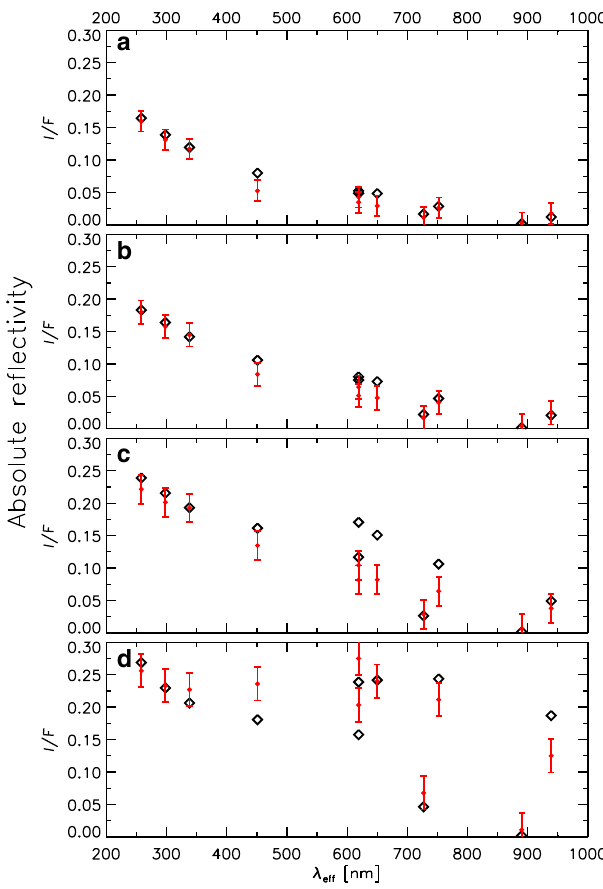
Fig. 3 Radiative transfer model fi t to the limb re fl ectivity scans. Panels show the re fl ectivity spectra from Fig. 2 (rhombs) and the limb-model results for the hazes at different altitudes (red dots with error bars). a z = 140 km, N p = 500 cm − 3 , H aerosol = 19 km. b z = 120 km, N p = 250 cm − 3 , H = 20 km. c z = 90 km, N = 100 cm − 3 , H = 21 km. d z = 40 km, aerosol aerosol N = 100 cm − 3 , H = 18 p aerosol z = 100 km, Fig. 2 shows that ( I/F ) ∼ 0.05 at the wavelength of the continuum red fi lters sensitive to the particles, which yields a number density for the particles of the order of N p ∼ 220 cm − 3 .